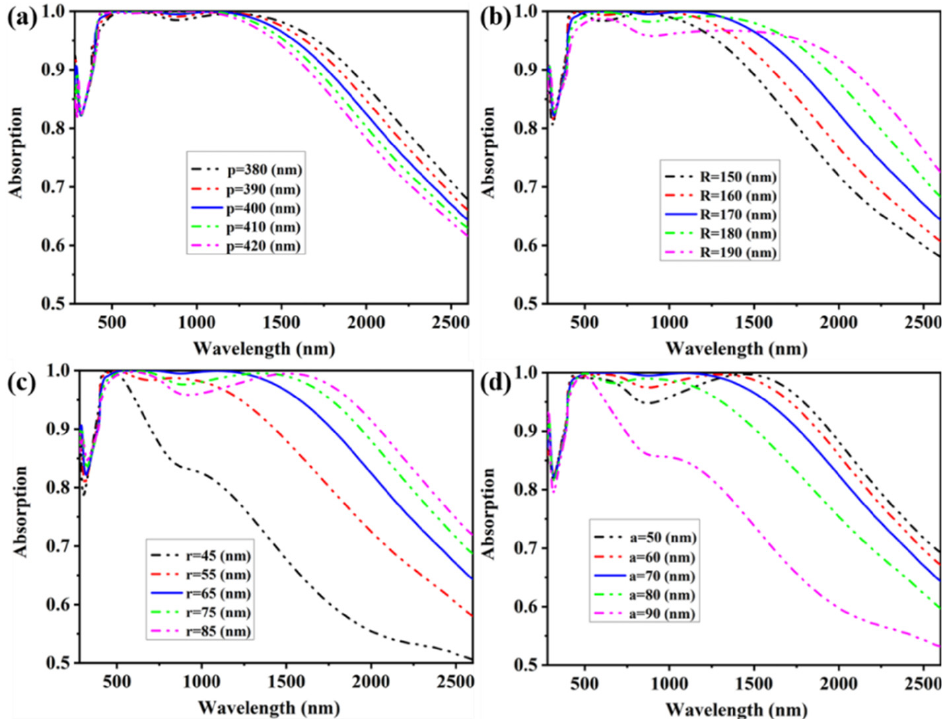
Figure 11. ( a ) Absorption spectrum at different periods. ( b – d ) The influence of the geometric parameters of the cross ellipse disks’ nanostructure on the absorption.